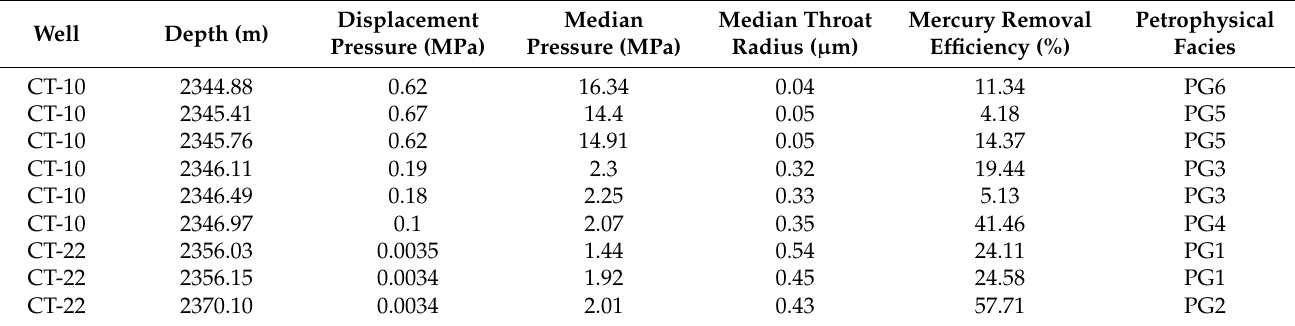
Table 2. Petrophysical facies classification results of CT-10 and CT-22 wells (part of data).